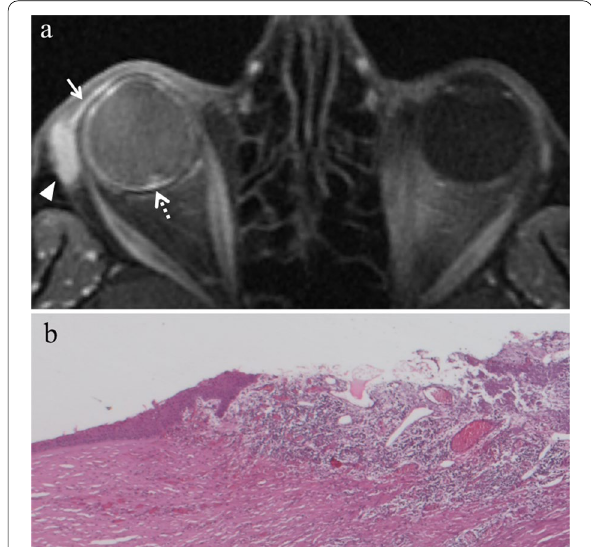
Fig. 10 A 58-year-old man with radiation-induced chronic conjunctivitis after proton-beam radiotherapy for choroidal melanoma of the right eye. The same patient as in Fig. 6. a Contrast-enhanced fat-suppressed T1-weighted image reveals thickening and marked enhancement of the conjunctiva of the right eye (white arrow). The right lacrimal gland is also enlarged with noticeable enhancement (white arrowhead). Note the residual irradiated tumor along the posterior aspect of the globe (dotted white arrow). b Sub-conjunctival inflammatory infiltrate, mainly composed of lymphocytes, ulcerating the overlying stratified squamous epithelium (H&E, original magnification 150 ×